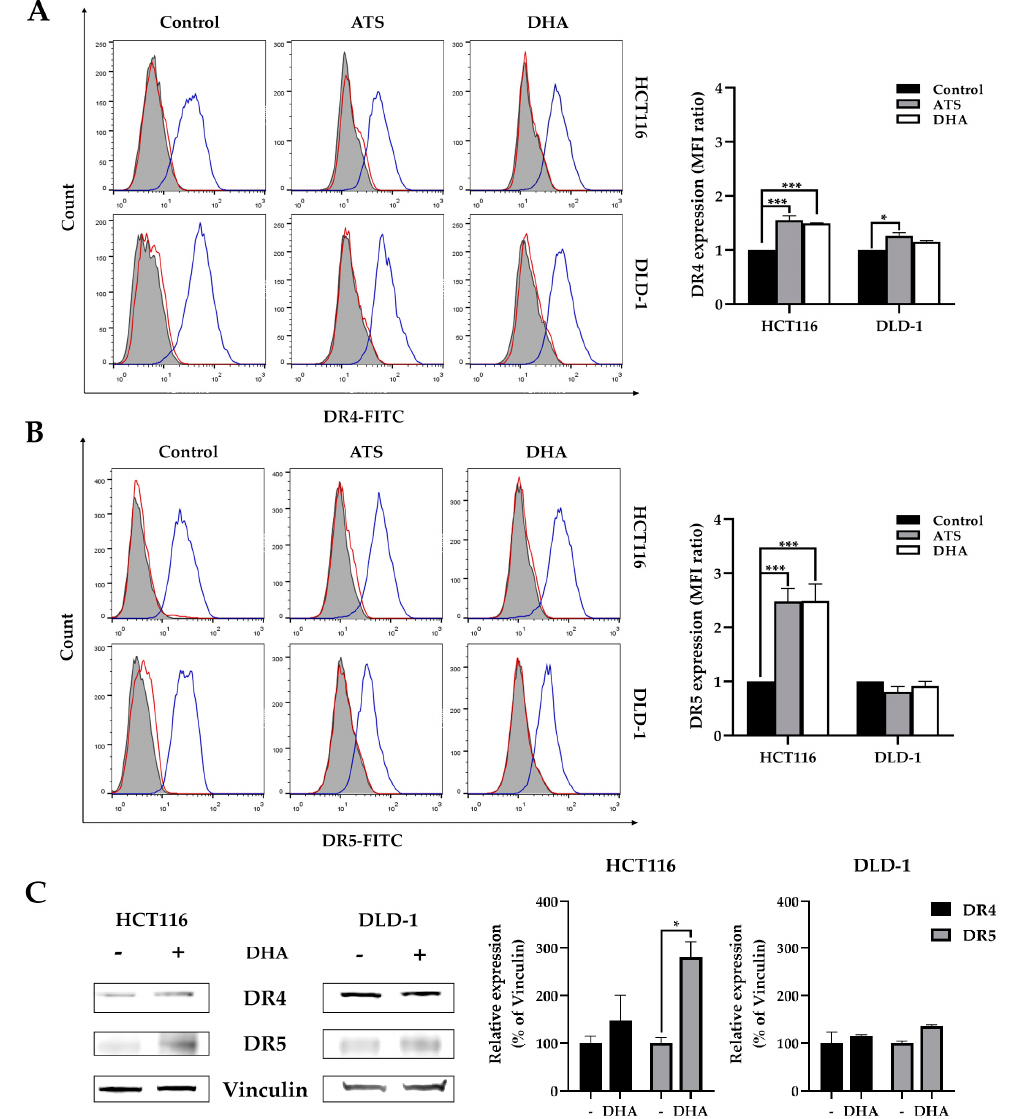
Figure 6. Artemisinin derivatives upregulate death receptor expression mainly in HCT116. HCT116 and DLD-1 were treated with 10 µ M ATS / DHA for 24 h and harvested to analyze cell surface DR4 ( A ) and DR5 ( B ) expression by immunofluorescent staining followed with flow cytometry. The left panel shows the histograms of death receptors, and the right figures show the mean fluorescence intensity (MFI) ratio relative to IgG isotype (red open line). The filled grey peaks represent unstained cells, and blue open lines represent DR4 or DR5, respectively. ( C ) DR4 and DR5 expression in 10 µ M DHA treated HCT116 and DLD-1 using vinculin as the loading control. Figure S1C shows the original Western blot. Data shown are mean ± SEM from two independent experiments. p values were analyzed by two-way ANOVA with Tukey’s multiple comparisons test in Graphpad Prism version 8.0. * 0.01< p ≤ 0.05, *** 0.0001< p ≤ 0.001.